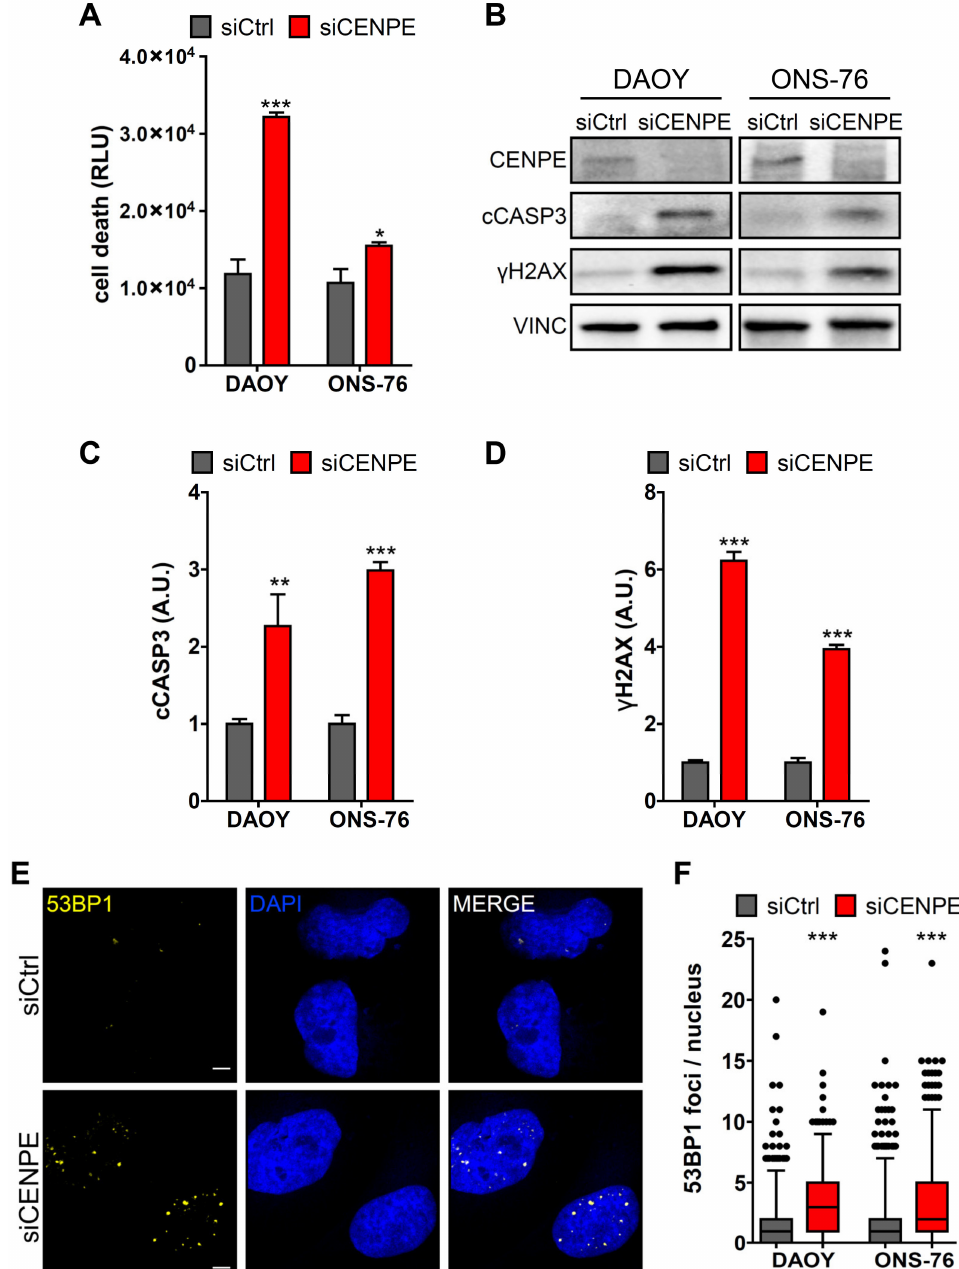
Figure 3. CENPE knockdown induces apoptosis and DNA damage in MB cells. ( A ) DAOY and ONS-76 cell death, measured by CellTox™ Green Cytotoxicity assay, 48 h after treatment with siCtrl or siCENPE. Values are plotted as Relative Light Unit (RLU). ( B ) Western blot analysis of total lysate from DAOY and ONS-75 cell lines, 48 h after treatment with siCtrl or siCENPE. The levels of CENPE, cleaved Caspase 3 (cCASP3) and γ H2AX were analyzed and the internal loading control was vinculin (VINC). The original images are shown in the Figures S1 and S2. ( C,D ) Quantification of the relative density of cCASP3 (C) and γ H2AX in DAOY and ONS-76 treated cells. ( E ) Representative image of DAOY cells processed for immunofluorescence 48 h after transfection with siCtrl or siCENPE and stained with anti-53BP1 antibody and DAPI. ( F ) Quantification of 53BP1 foci per nucleus in cells treated as in ( E ). All quantifications were based on at least three independent biological replicates. 53BP1 foci were counted in >300 cells per condition. Error bars, SEM. *, p < 0.05, **, p < 0.01; two-tailed Student t -test for blots and CellTox™ assay. ***, p < 0.001 Mann–Withney U test for 53BP1 foci. Scale bars, 5 µ m. A.U., arbitrary